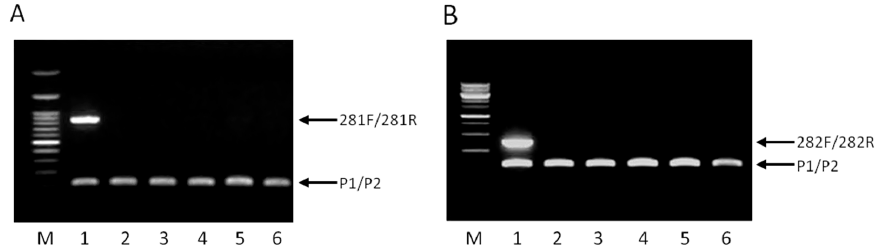
Figure 2. Agarose gel electrophoresis of PCR products from multiplex PCR assay. ( A ) Lanes: 1,